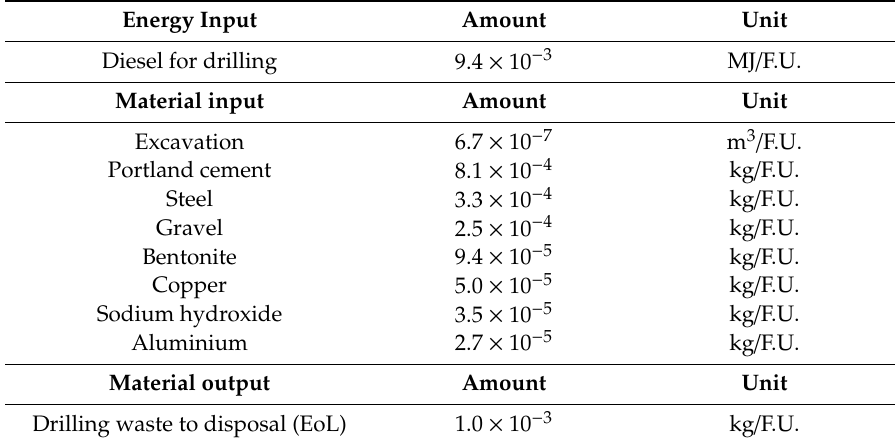
Table 4. Main material and energy inputs employed in the commissioning phase. The cut-o ff is set at 2% of the total mass, to reduce the number of inputs reported. Complete information can be found in the Supplementary Materials.